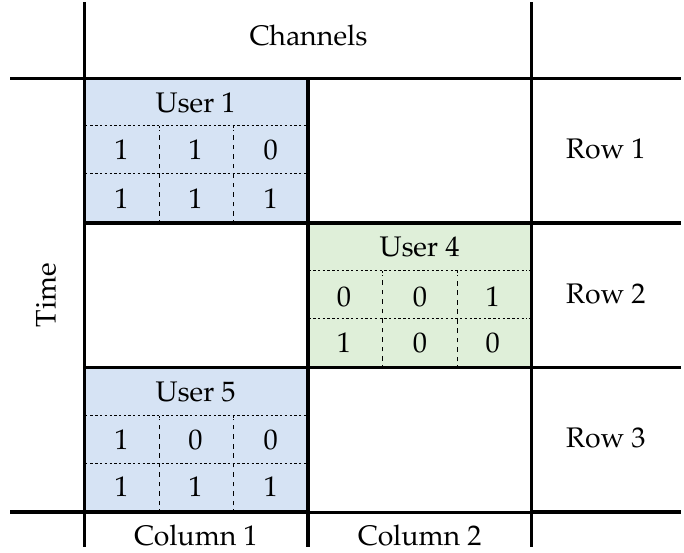
Figure 8. Training matrix for a secondary user (SU) with 50% collaboration and random selection.